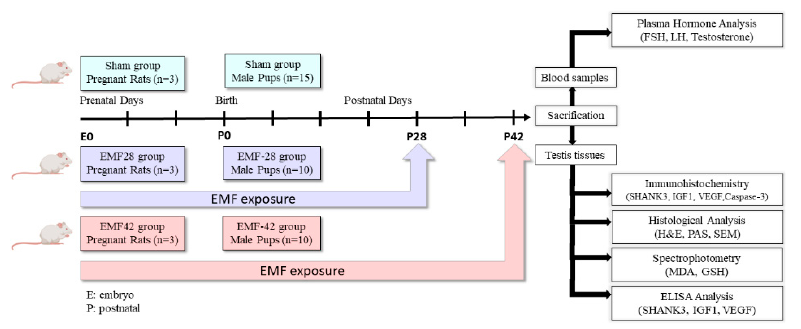
Figure 1. The scheme of the experiment. EMF, electromagnetic field; FSH, follicle-stimulating hormone; LH, luteinizing hormone; SHANK3, SH3 and multiple ankyrin repeat domain; IGF1, insulin-like growth factor-1; VEGF, vascular endothelial growth factor; H&E, hematoxylin-eosin; PAS, periodic acid-Schiff; SEM, scanning electron microscopy; MDA, malondialdehyde; GSH, glutathione.